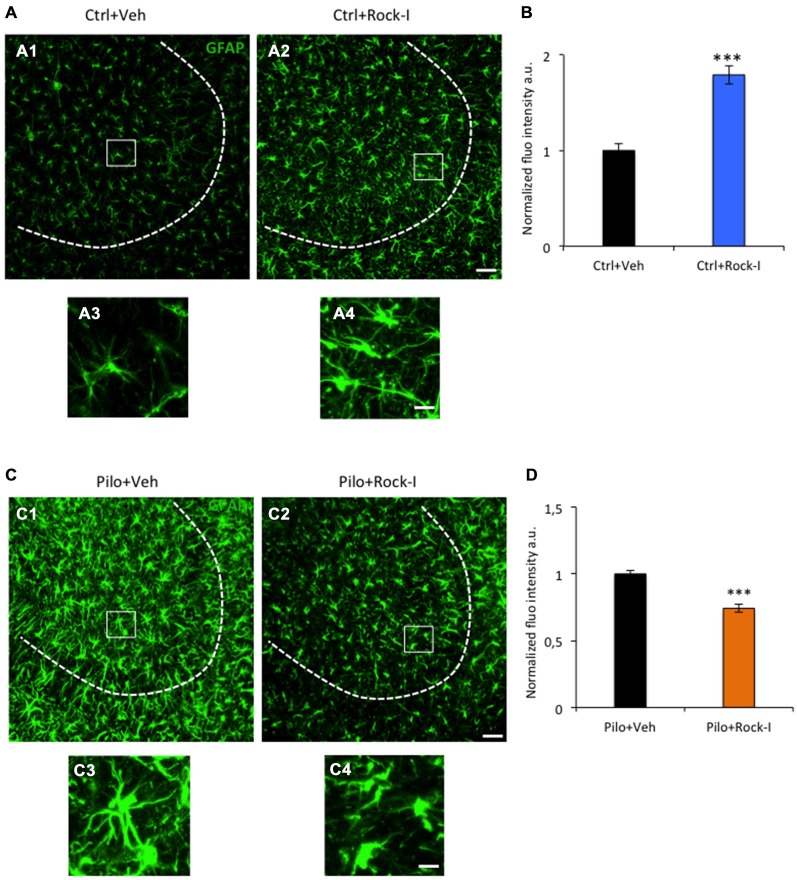
Different glial responses upon Y-27632 treatment in control and post-SE conditions. (A) Representative images of GFAP-immunopositive astrocytes (green) in control vehicle-treated (A1,3) and Y27632-treated (A2,4) rats. Dotted lines indicate the pyramidal cell layer of the CA3. The white squares in (A1,2) show higher magnifications of GFAP labeling (A3,4). (B) The histogram represents the quantification of the fluorescence intensity (n = 3 for control vehicle-treated; n = 4 for control Y-27632-treated). Data are means ± SEM; ***p < 0.001, p values obtained using Mann–Whitney rank-sum test analysis. (C) Representative images of GFAP-immunopositive astrocytes (green) in the CA3 region in pilocarpine vehicle-treated (C1,3) and pilocarpine Y27632-treated (C2,4) rats. Dotted lines indicate the pyramidal cell layer of the CA3 region. The white squares in (C1,2) show higher magnifications of GFAP labeling (C3,4). (D) The histogram represents the quantification of the fluorescence intensity (n = 4 for pilocarpine vehicle-treated; n = 8 for pilocarpine Y-27632-treated). Data are means ± SEM; ***p < 0.001, p values obtained using Mann–Whitney rank-sum test analysis. Scale bars: A1, 2; C1, 2 = 20μm. A3, 4; C3, 4 = 15 μm.